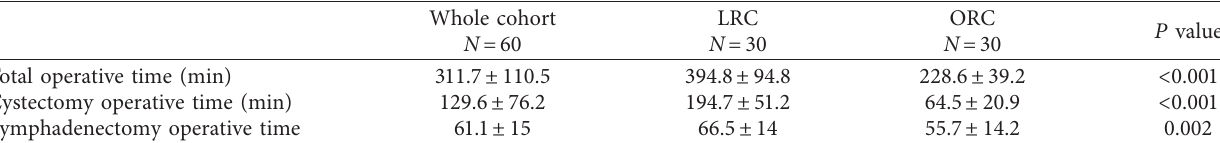
Table 3: Comparison of cystectomy and lymphadenectomy operative time (minutes) between the LRC and ORC groups. Whole